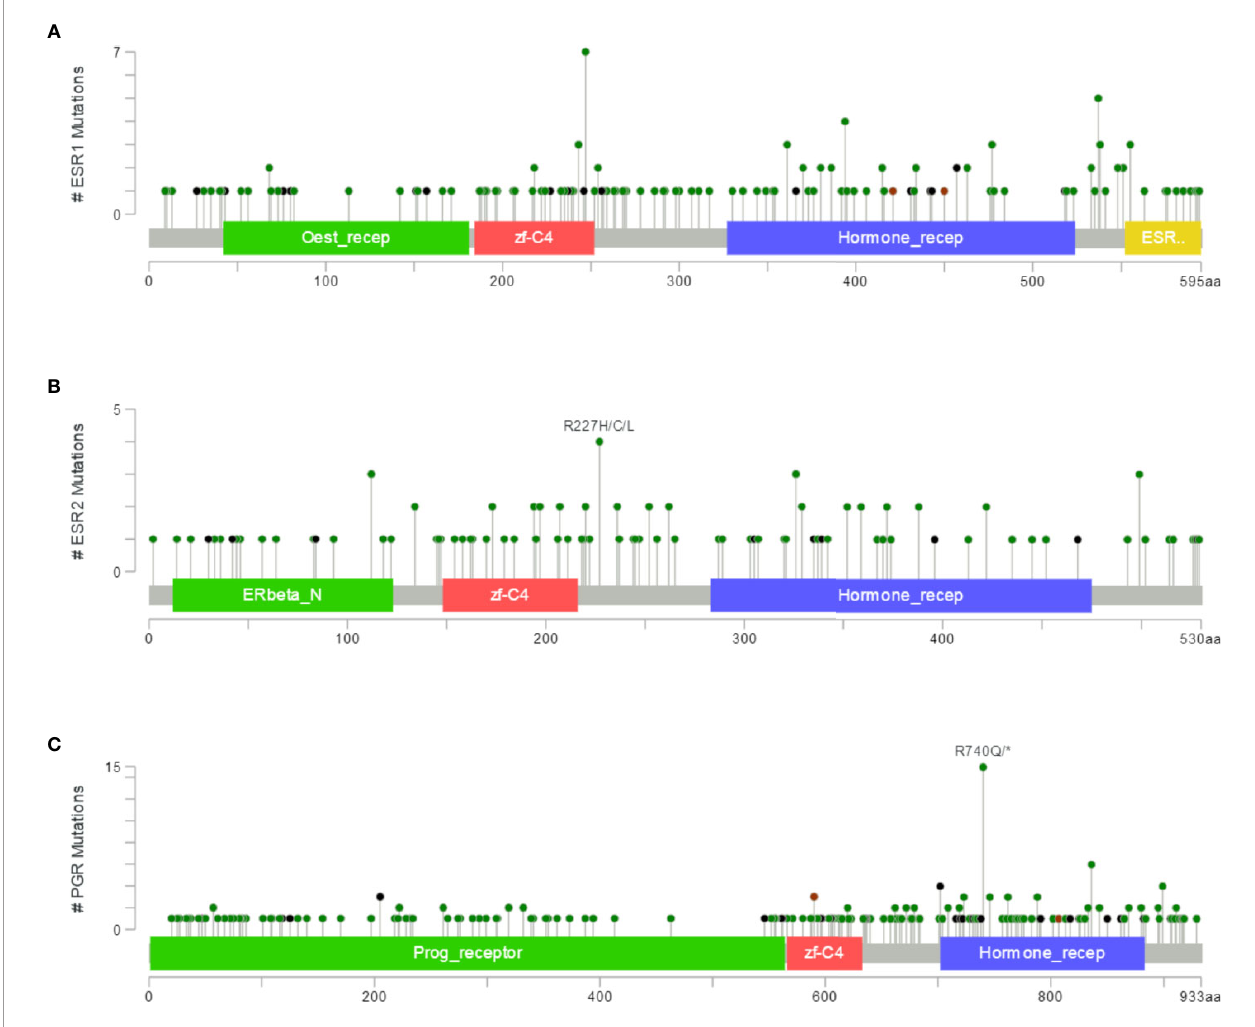
FIGURE 8 | Mutations in ESR1 , ESR2 , and PGR across multiple cancer types. (A) Mutation frequency in ESR1 across multiple cancer types. (B) Mutation frequency in ESR2 across multiple cancer types. (C) Mutation frequency in PGR across multiple cancer